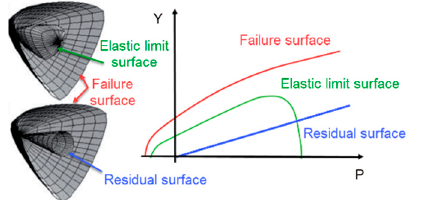
Figure 9. The RHT model used for concrete; based on [48].